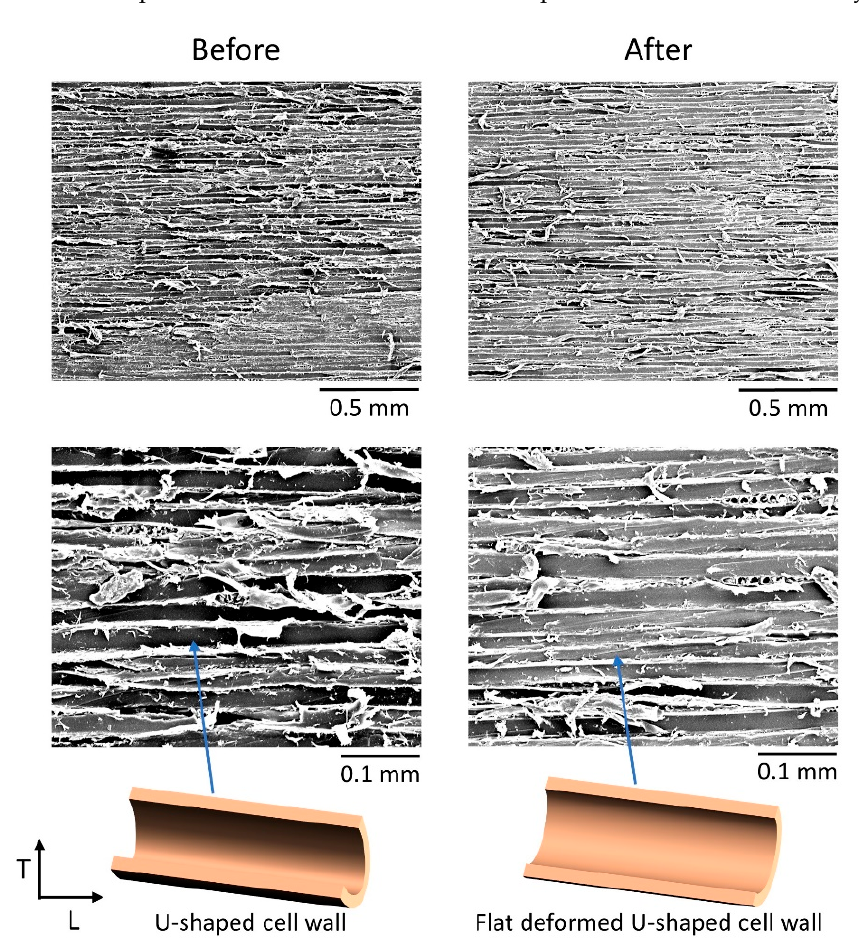
Figure 11. SEM images of entry 6 before and after heat treatment, and images of the cell walls on wood surfaces.